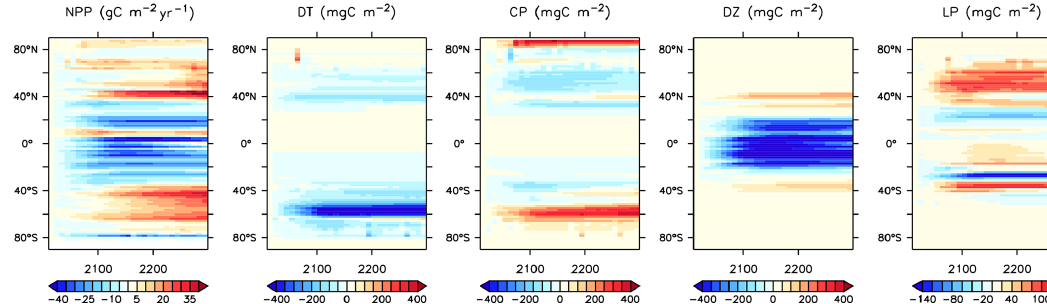
Figure 25. Modelled changes in zonally averaged and depth-integrated NPP, and phytoplankton biomass, from 2014 to 2294.